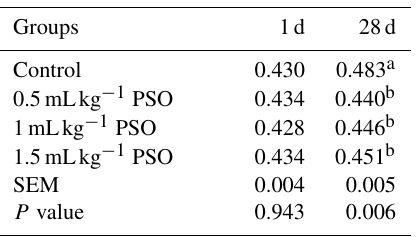
Table 5. Effect of PSO on TBARS of egg values of yolk in laying hens (mgMDAkg − 1